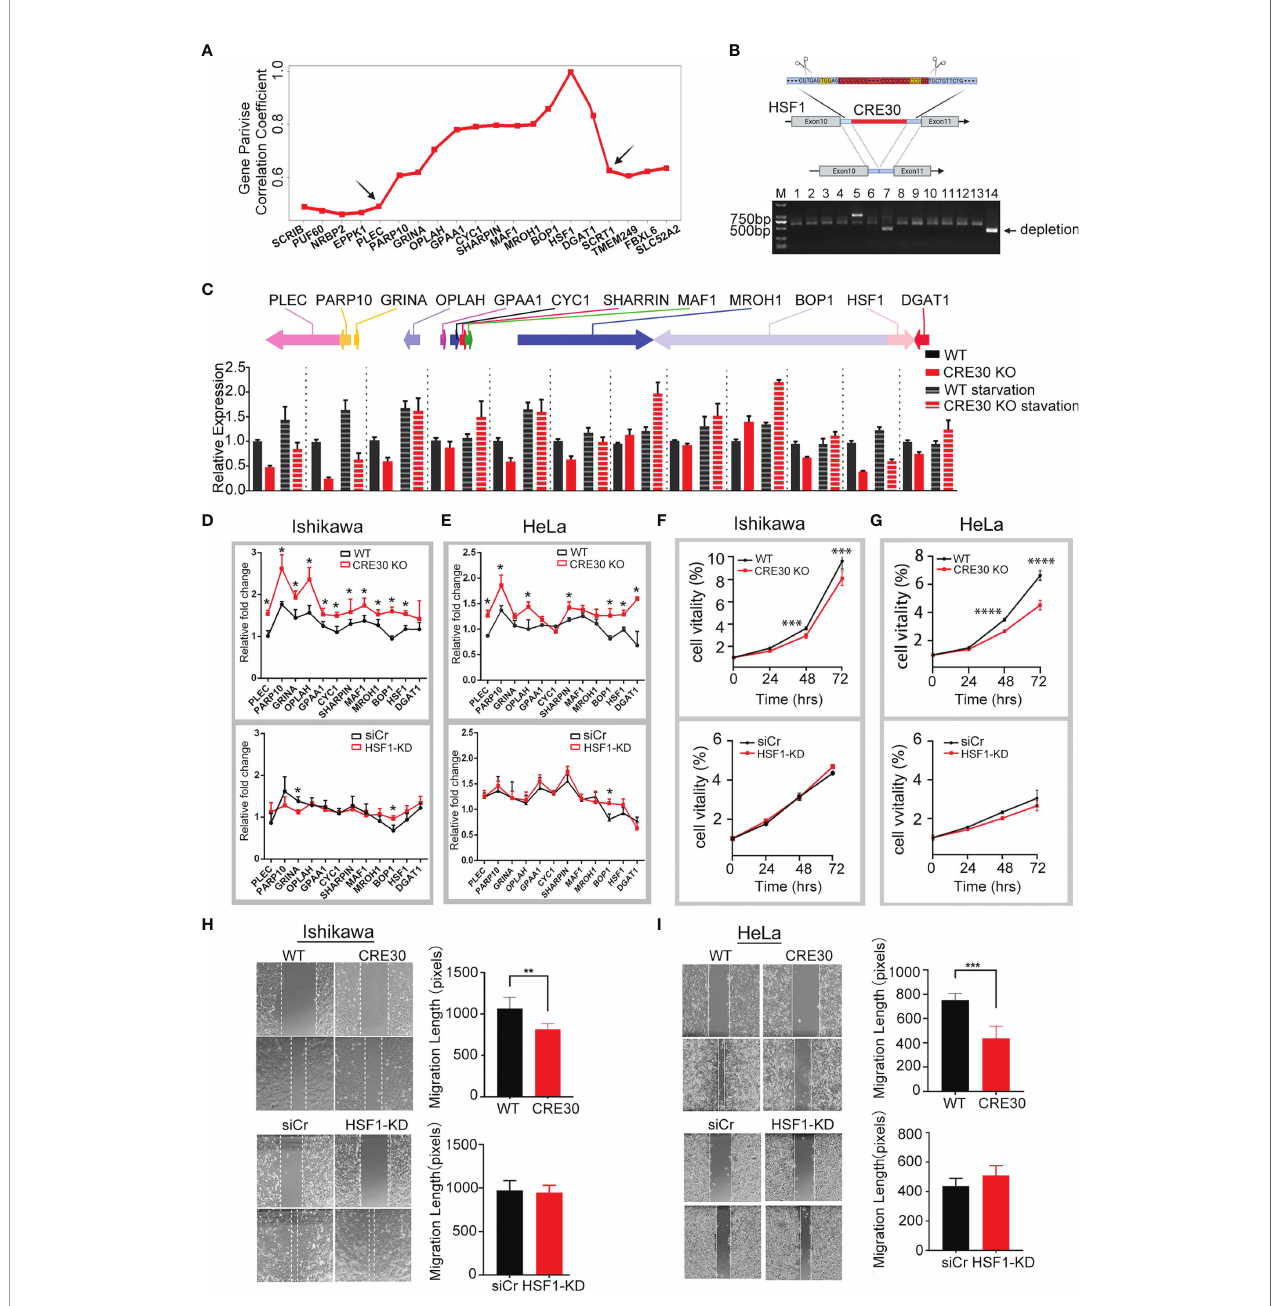
FIGURE 3 | CRE30 deletion in sub-CRR95 affected gene regulation and tumor cell phenotype. (A) Distribution of expression correlation coef fi cients among genes around sub-CRR95. Arrows indicate the boundary sites. (B) Upper panel, schematic showing CRE30 location and CRISPR deletion process in the HSF1 gene region; the red rectangle indicates the CRE30 locus, and PAM sequences used for CRISPR are shown in yellow. Lower panel, PCR bands for both wild-type and deletion clones. PCR of wild-type clones results in two bands, while only one band (less than 500 bp) was obtained from the double deletion clone. (C) qPCR analysis for sub-CRR95 gene expression following deletion of CRE30 in cells with regular or serum starvation culture. Black columns indicate wild-type cells, and red columns indicate CRE30 KO cells (n = 3). (D, E) Relative fold change of sub-CRR95 gene expression under serum-starvation stress in Ishikawa (D) and HeLa (E) cells. Expression ratio of serum starvation to regular condition is shown to re fl ect gene regulation under stress. Upper panel shows differences between wild-type (black) and CRE30 KO cells (red) cells; lower panel compares HSF1 knockdown (red) with control (black) groups in wild-type cells (n = 3). Asterisks indicate the signi fi cant differences. (F, G) Cell proliferation in response to CRE30 deletion (upper panel) and HSF1 knockdown (lower panel) as determined by MTT assays in Ishikawa (F) and HeLa cells (G) (n ≥ 6). (H, I) Wound healing experiments were used to evaluate cell migration in response to CRE30 deletion (upper panel) and HSF1 knockdown (lower panel) in Ishikawa (H) and HeLa (I) cells (n ≥ 4). T-tests were performed, and signi fi cant differences were indicated by * (p < 0.05), ** (p < 0.01), *** (p < 0.001) and **** (p <